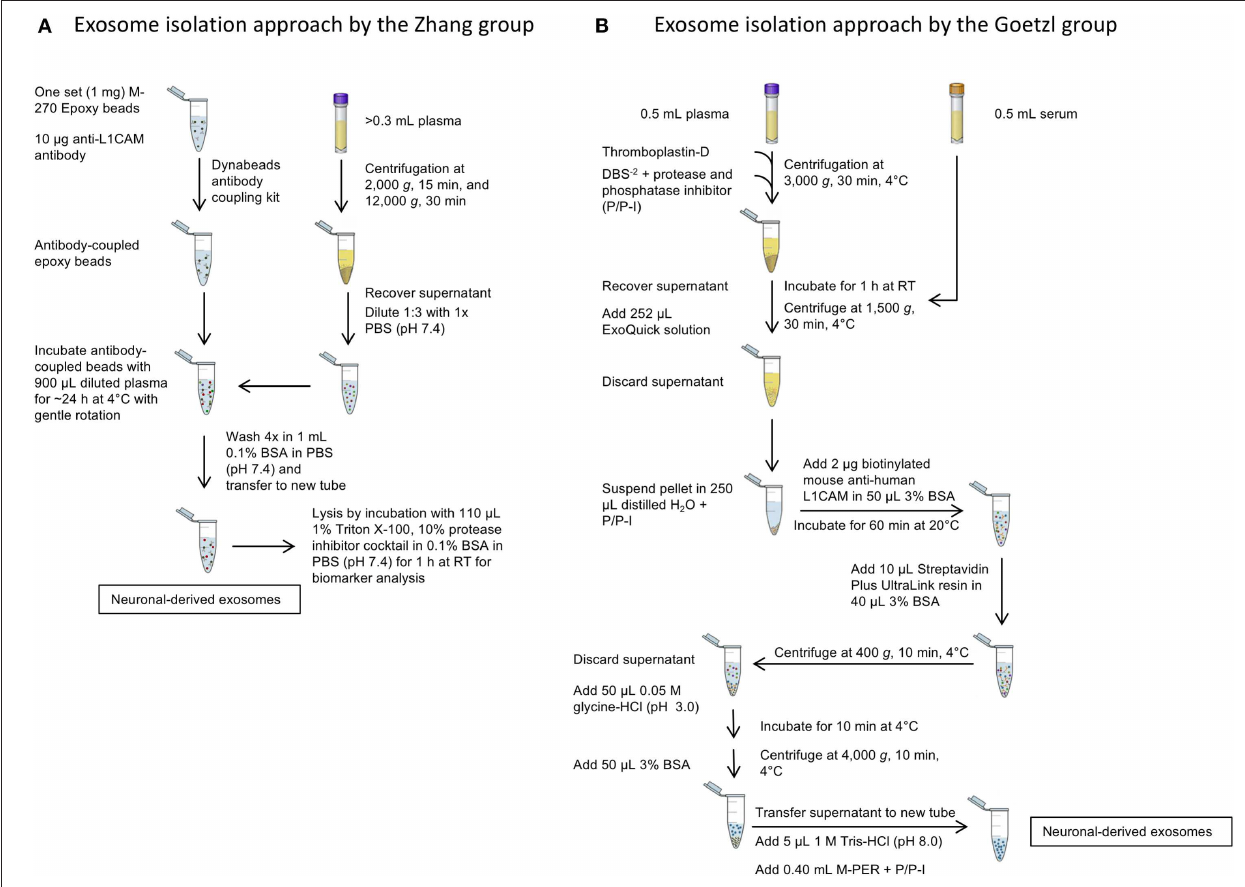
FIGURE 3 | Isolation of CNS-derived exosomes from blood. (A) The protocol of the Zhang group relies on anti-L1CAM antibody-coupled epoxy beads, which are incubated directly with diluted plasma to bind neuronal exosomes. The following washing steps in 0.1% BSA remove unbound, non-neuronal exosomes in the sample. (B) The method described by Goetzl et al. The protocol uses first an exosome precipitation step by ExoQuick followed by capturing specifically neuronal exosomes with biotinylated anti-L1CAM antibodies and a streptavidin-conjugated resin. Subsequent washing steps remove non-neuronal exosomes as well as the antibody and resin to yield neuronal